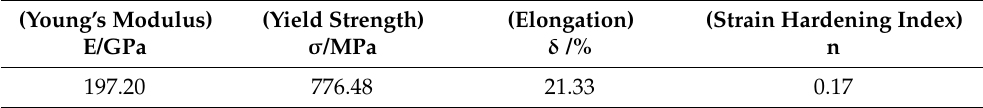
Table 1. Mechanical properties of Q&P980.